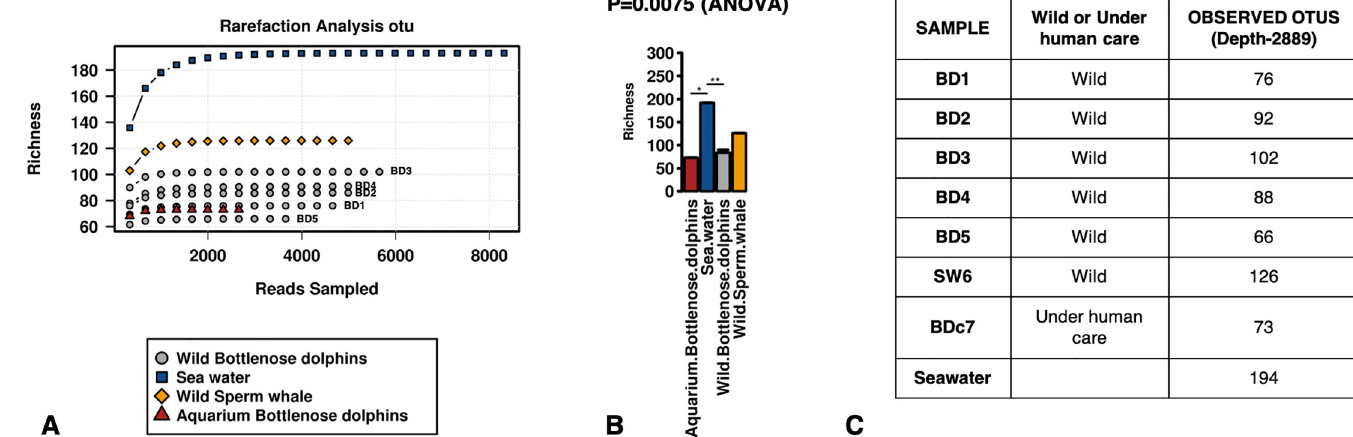
PLOS ONE | https://doi.org/10.1371/journal.pone.0235537 July 2,